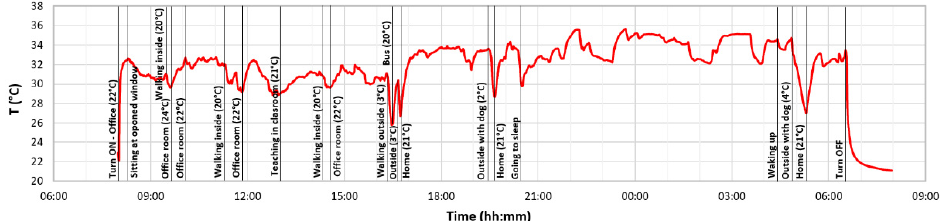
Figure 10. Functional testing—24-h peripheral temperature analysis with marked events and envi- ronmental temperatures.